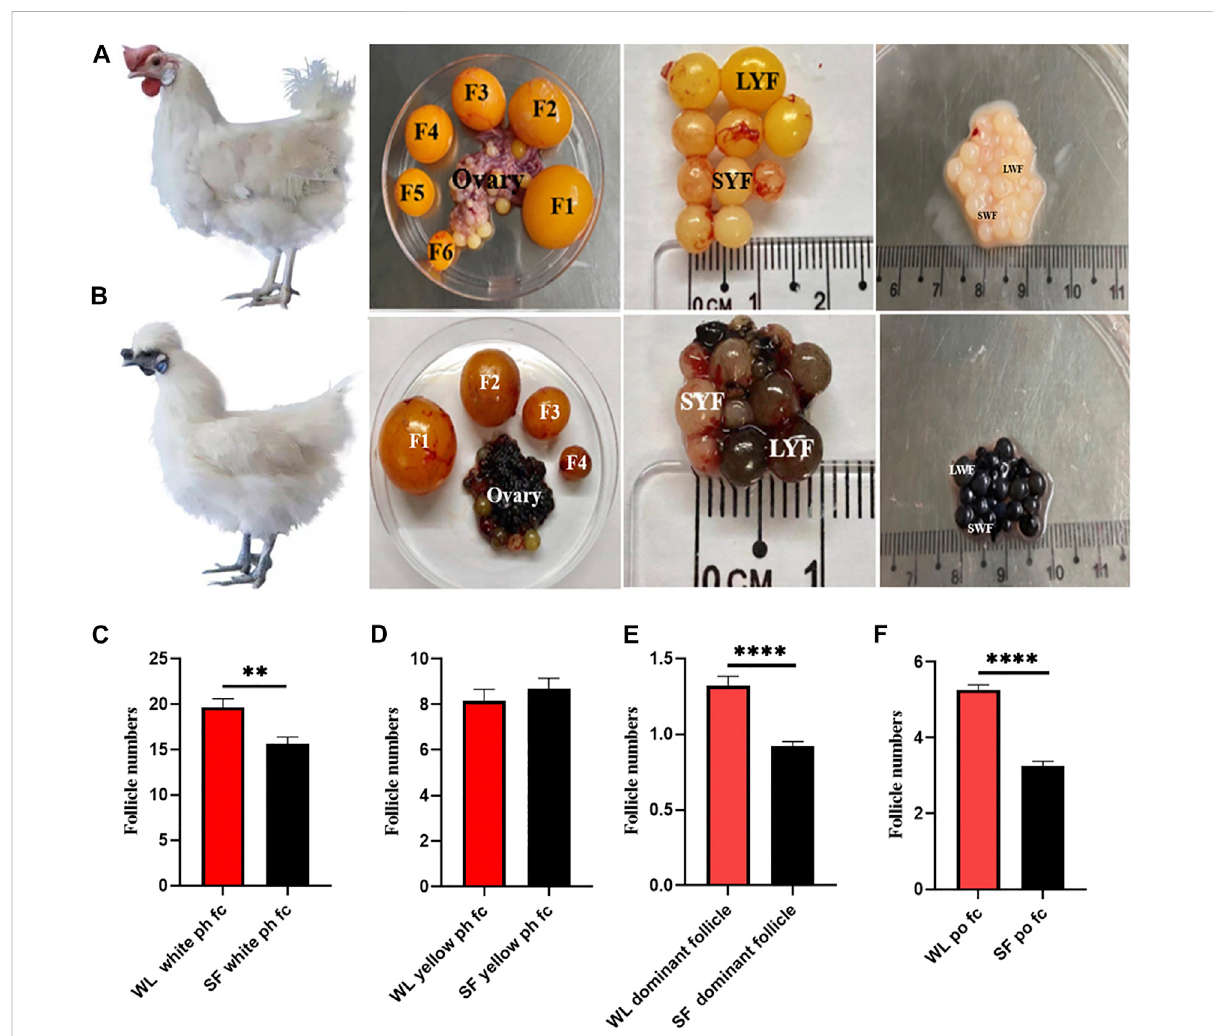
FIGURE 1 Follicular morphology of WL and SF. (A) Morphology of WL prehierarchical and preovulatory follicles. (B) Morphology of SF prehierarchical and preovulatoryfollicles.(SWF,smallwhitefollicle;LWF,largewhitefollicle;SYF,smallyellowfollicle;LYF,largeyellowfollicle). (C) Comparethenumber of WL and SF white prehierarchical follicles. (D) Compare the number of WL and SF yellow prehierarchical follicles. (E) Compare the number of WL and SF dominant follicles. (F) Compare the number of WL and SF preovulatory